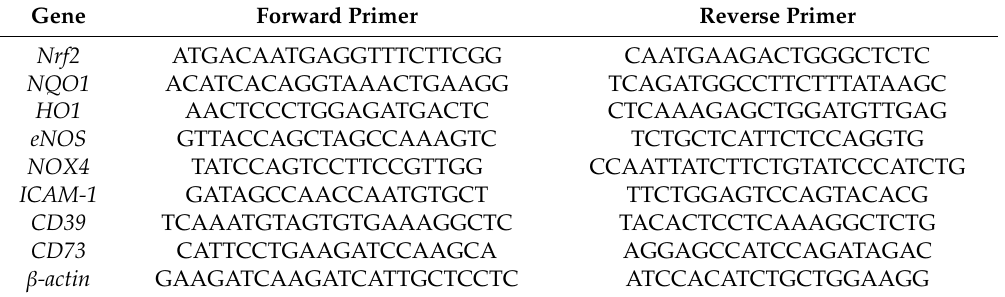
Table 1. The nucleotide sequences of the PCR primers used to assay gene expression by